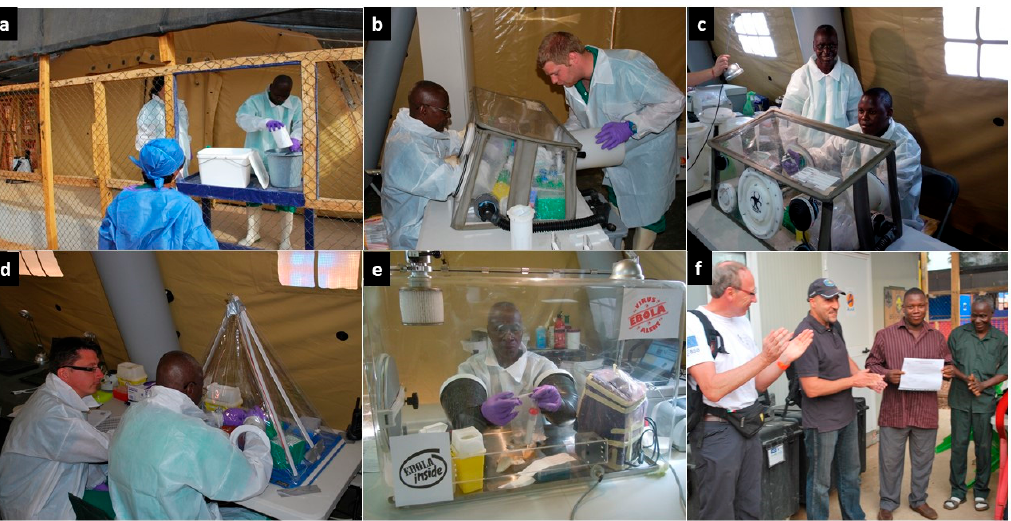
Figure 4. Biosafety training and qPCR procedures. A double fence surrounded the laboratory, the first to control entry to the site and perform biosafety measures (temperature monitoring, hand and shoe decontamination), the second to restrict access to the laboratory staff. ( a ) Samples were received through a window in the internal fence. The training focused on handling Ebola samples inside a negative-pressure glovebox, ( b ) first under supervision and then ( c ) autonomously, ( d ) to prepare a 96-multiwell plate for the qPCR inside a disposable glovebox, and ( e ) to perform biochemical tests. ( f ) Certificates of attendance were issued at the end of the JiTT program.